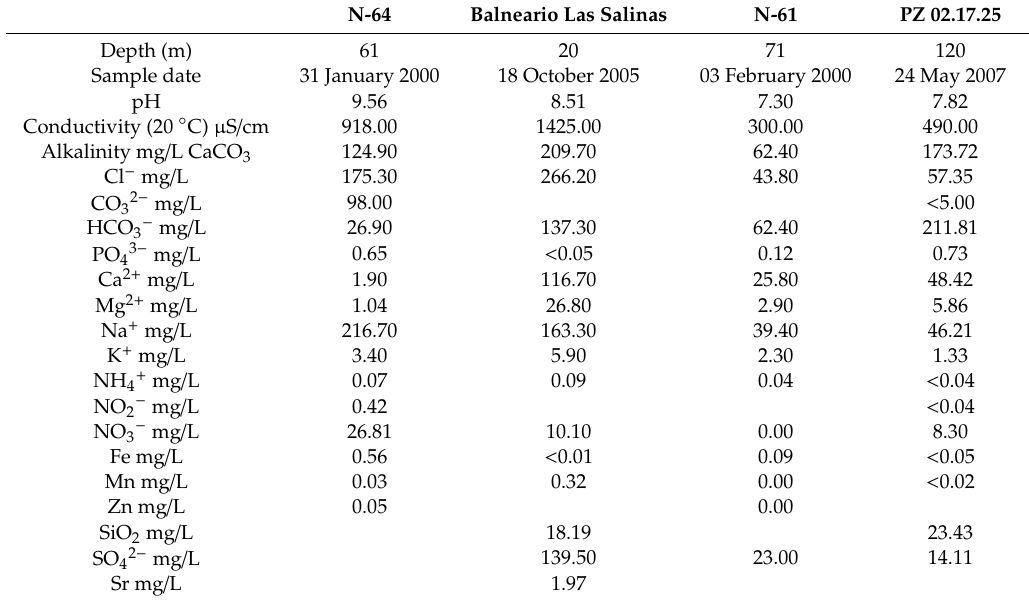
Table 1. Groundwater chemical analysis for the water points near the Lagunas Reales (IGME, CHD). N-64 and Balneario Las Salinas correspond to points 1 and 3 in Figure 1, respectively. N-61 and PZ 02.17.25 are out of the mapped